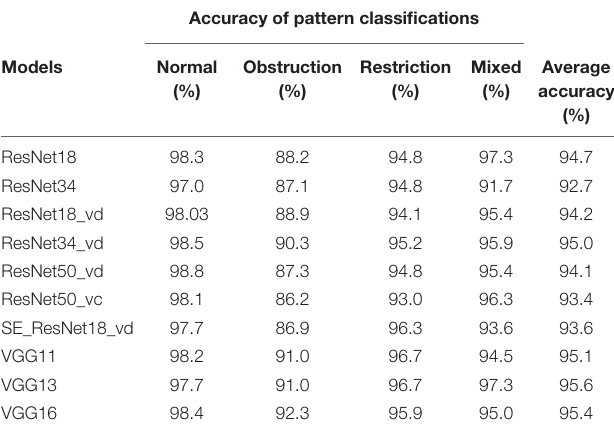
TABLE 3 | The performance of 10 deep learning-based models in the test